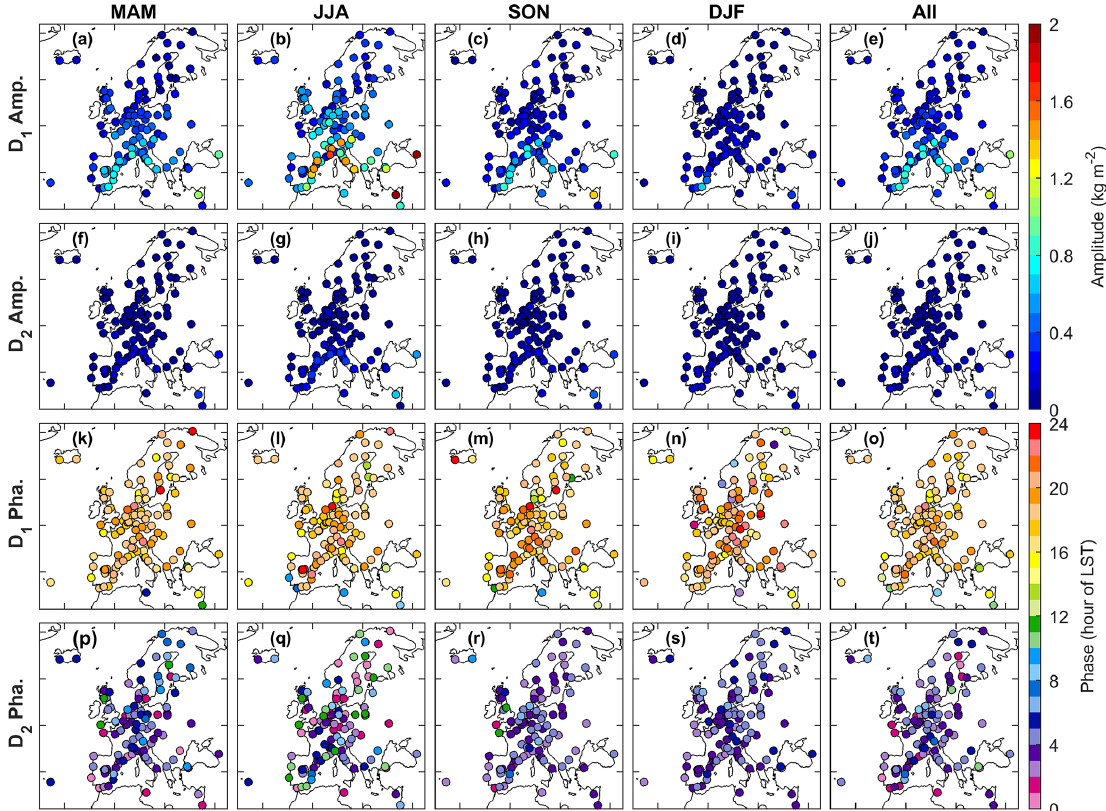
Figure 6. Plots of the amplitudes (a, f) and phases (k, p) for the first ( D 1 ) and second ( D 2 ) harmonics of the diurnal GPS IWV cycle averaged in March, April, and May (MAM; spring) at each station, respectively. The other subplots are for JJA (summer); September, October, and November (SON; autumn); December, January, and February (DJF; winter); and annual, from left to right, respectively. The phases are in local solar time (LST) at the peak of associated